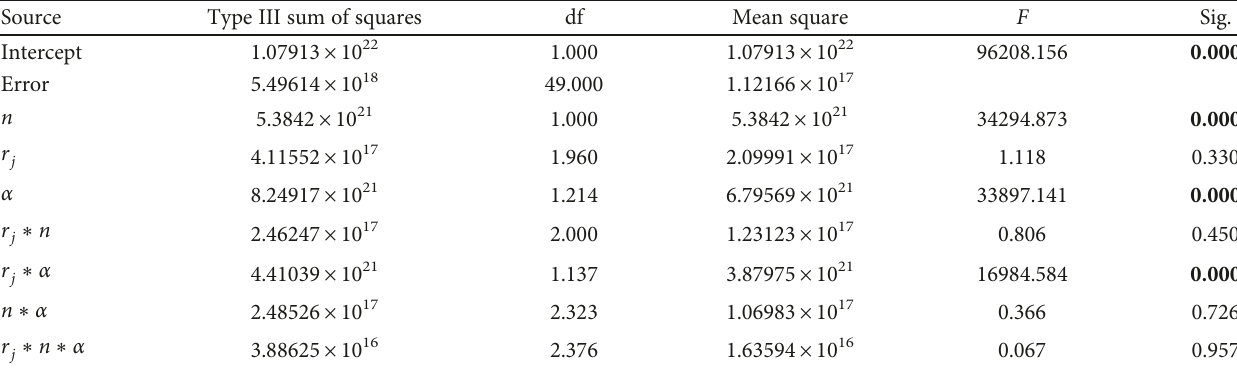
Table 8: Tests of between-subject e ff ects to HV of